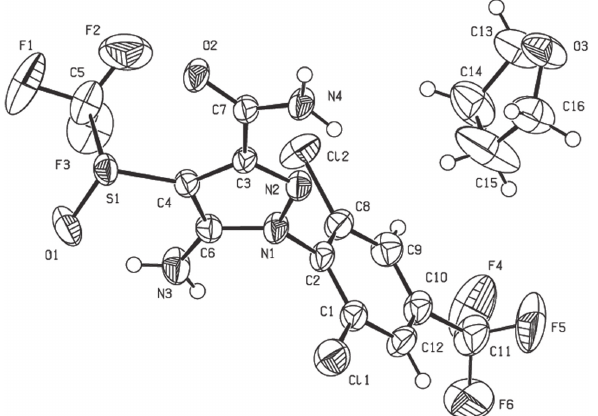
Table 2: Fractional atomic coordinates and isotropic or equivalent isotropic displacement parameters (Å 2